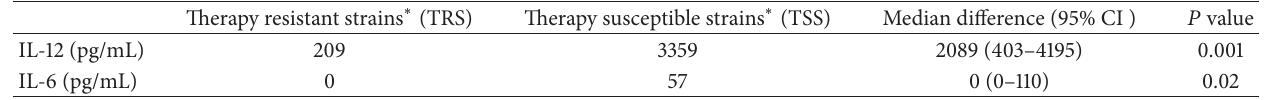
Table 2: Concentration of cytokines & in supernatant of THP-1 cells stimulated with different H. pylori antigens.